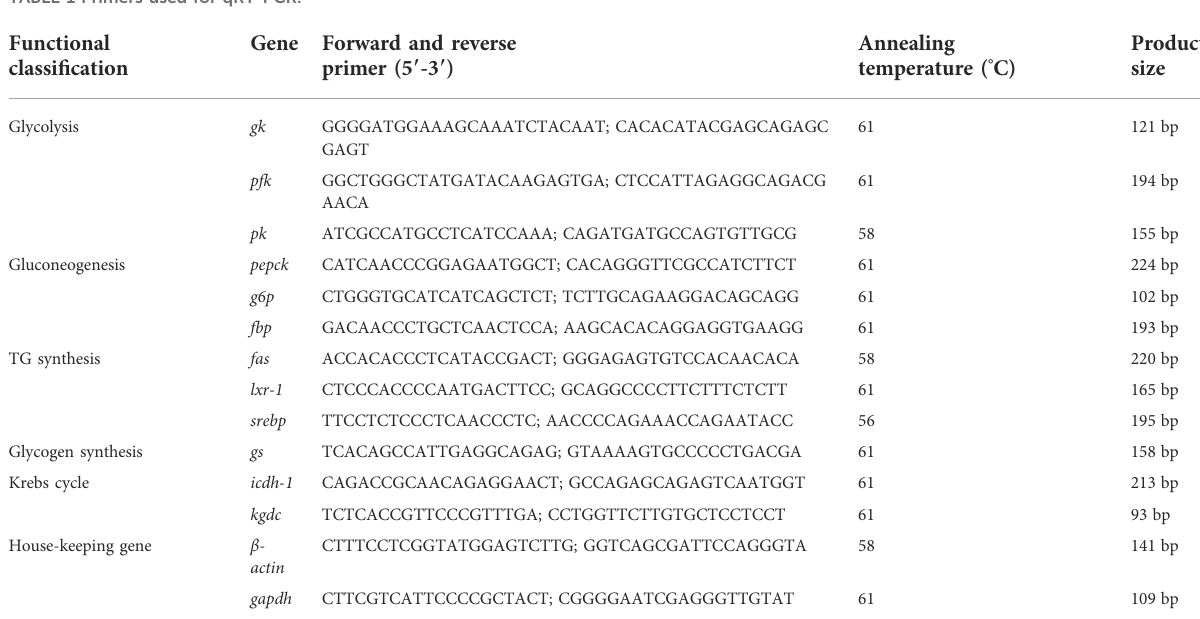
TABLE 1 Primers used for